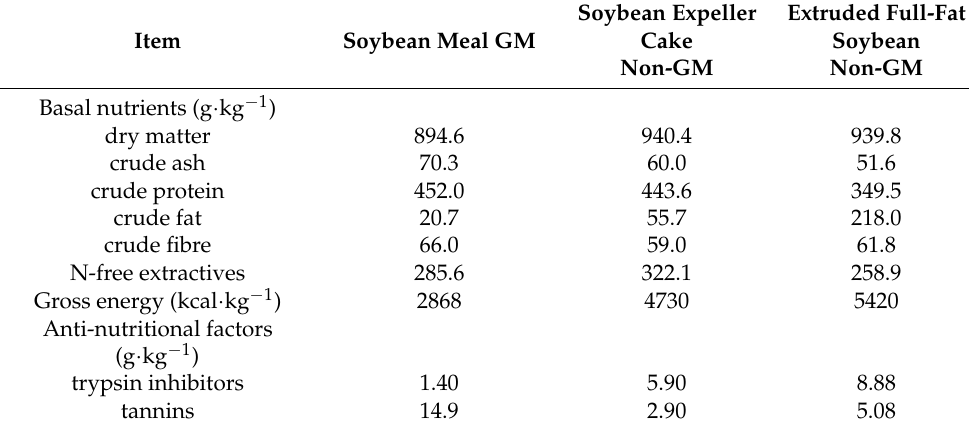
Table 1. Chemical composition of soybean feeds.